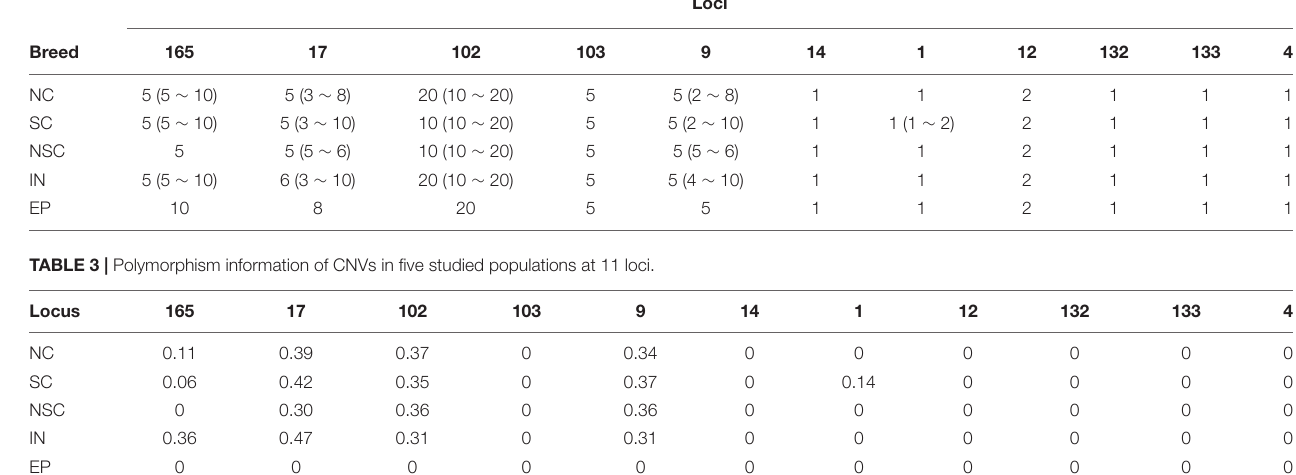
TABLE 2 | Median number and range of copy variations of the studied horse populations at 11 loci. Breed